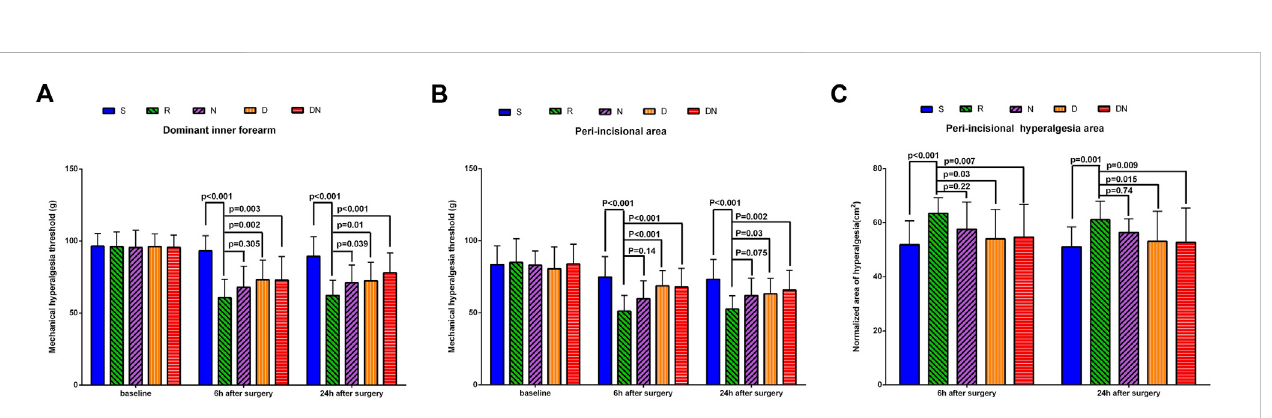
FIGURE 3 Postoperative mechanical pain threshold and normalized area of hyperalgesia. Mechanical pain threshold on the dominant forearm (A) and around the incision (B) and normalized area of hyperalgesia (C) were tested before and 6 h and 24 h after surgery with Von Frey fi laments. Group S: Intraoperative sufentanil 0.20 μ g kg − 1 and pre-anesthesia saline; Group R: Intraoperative remifentanil 0.20 μ g kg − 1 min − 1 and pre-anesthesia saline; Group N: Intraoperative remifentanil0.20 μ g kg − 1 min − 1 andpre-anesthesianalmefene0.20 μ g kg − 1 ;GroupD:Intraoperativeremifentanil0.20 μ g kg − 1 min − 1